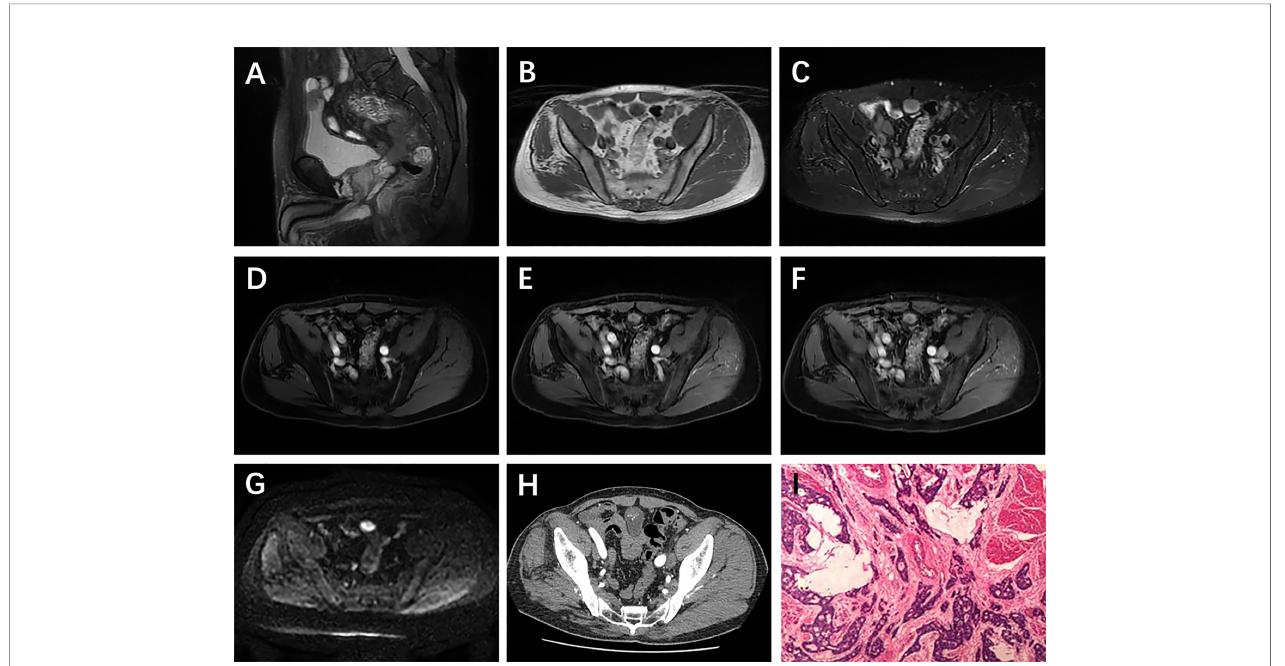
FIGURE 3 | A 62-year-old man with urachal carcinoma presented with painless gross hematuria. Sagittal T2WI (A) showed a solid mass in the urachus; slightly low signal intensity on T1WI (B) and high signal intensity on T2WI (C) ; axial dynamic contrast-enhanced LAVA-Flex images showed no obvious enhancement in arterial phase, but obvious enhancement in venous phase and delayed phase (D – F) ; restricted diffusion on DWI (G) ; multiple spotted calci fi cations on axial unenhanced CT scan (H) ; pathological fi ndings showed moderately differentiated adenocarcinoma (intestinal type) (I) .